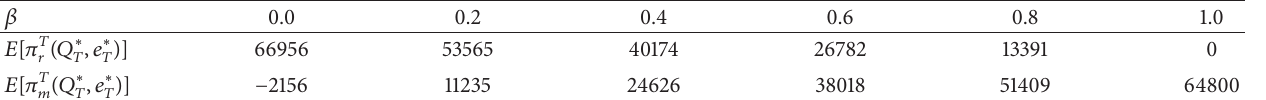
Table 2: Effect of 𝛽 on the allocation of the expected supply chain profit between two firms.